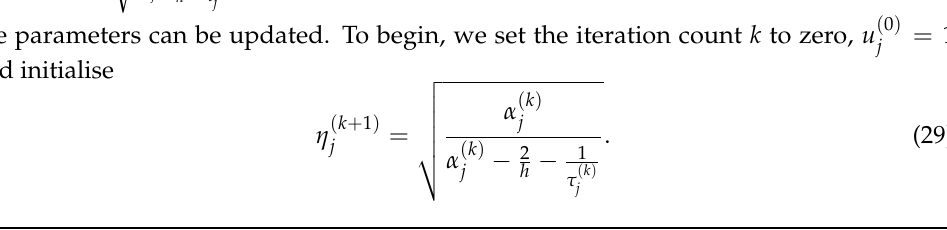
Algorithm 1: Non-linear state-space identification algorithm with sparse Bayesian and Stein approach